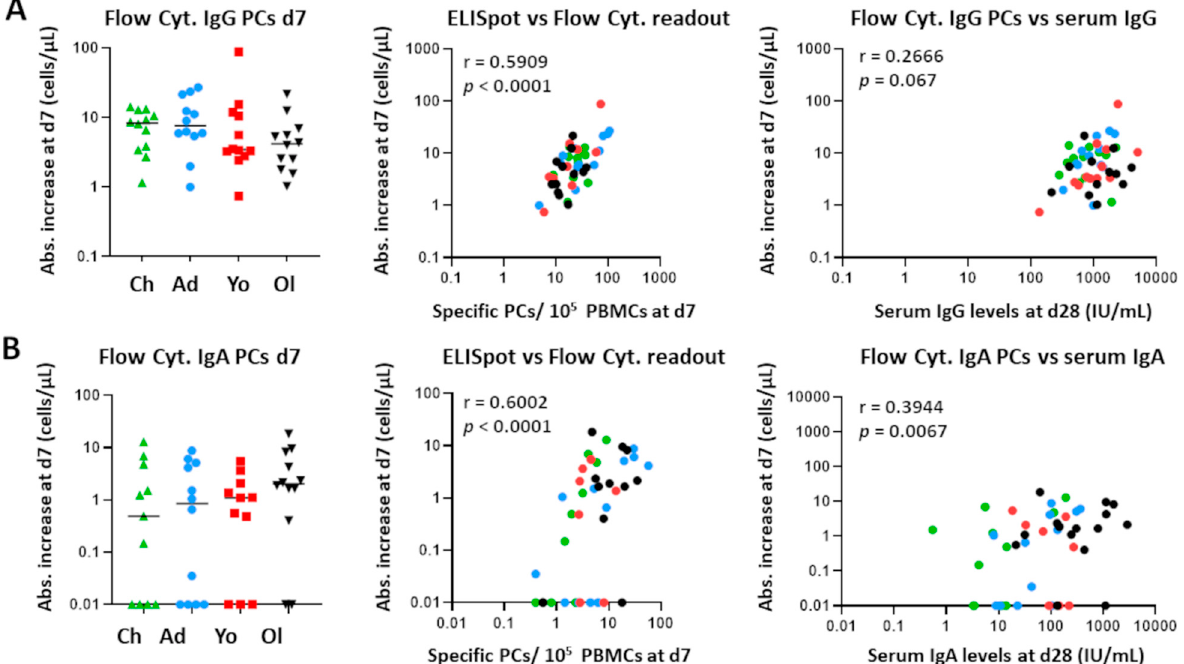
Figure 5. Correlation between cellular changes as measured by flow cytometry and ELISpot, and the correlation between plasma cell expansion and vaccine-specific serum Igs 28 days postvaccination. ( A ) Left panel: expansion of IgG+ plasma cells (day 7) per individual, expressed as absolute increase in cells/ µ L. Middle panel: correlation between the ELISpot and flow cytometry readout for IgG+ plasma cells. Right panel: correlation between the increase in plasma cells (as measured by flow cytometry) and the vaccine-specific serum IgG levels (day 28). ( B ) Left panel: expansion of IgA1+ plasma cells (day 7) per individual, expressed as absolute increase in cells/ µ L. Middle panel: correlation between the ELISpot and flow cytometry readout for IgA+ plasma cells. Right panel: correlation between the increase in plasma cells (as measured by flow cytometry) and the vaccine-specific serum IgA levels (day 28). Each dot represents a single donor. Of note, for visualization purposes, all absolute increases lower than 0.01 were set to 0.01. The original values were used to calculate the Spearman correlations. Flow Cyt. = flow cytometry; PCs = plasma cells; d = days after vaccination; Abs. =